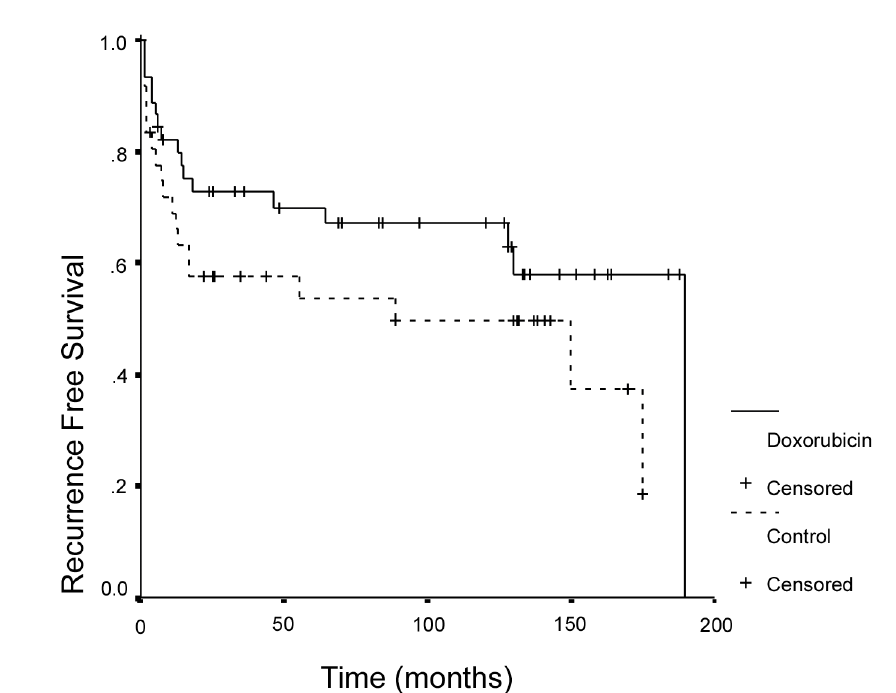
Figure 1 – Recurrence free survival curves of doxorubicin group (solid line) and control group (dotted line). Log rank test, p = 0.12.